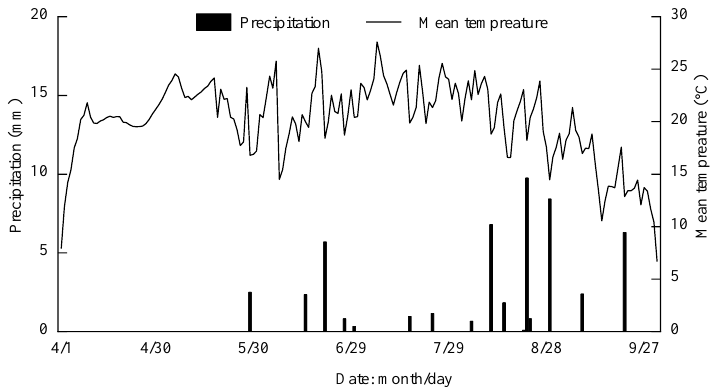
Figure 1. Meteorological characteristics of the experimental site from April to October in 2020.